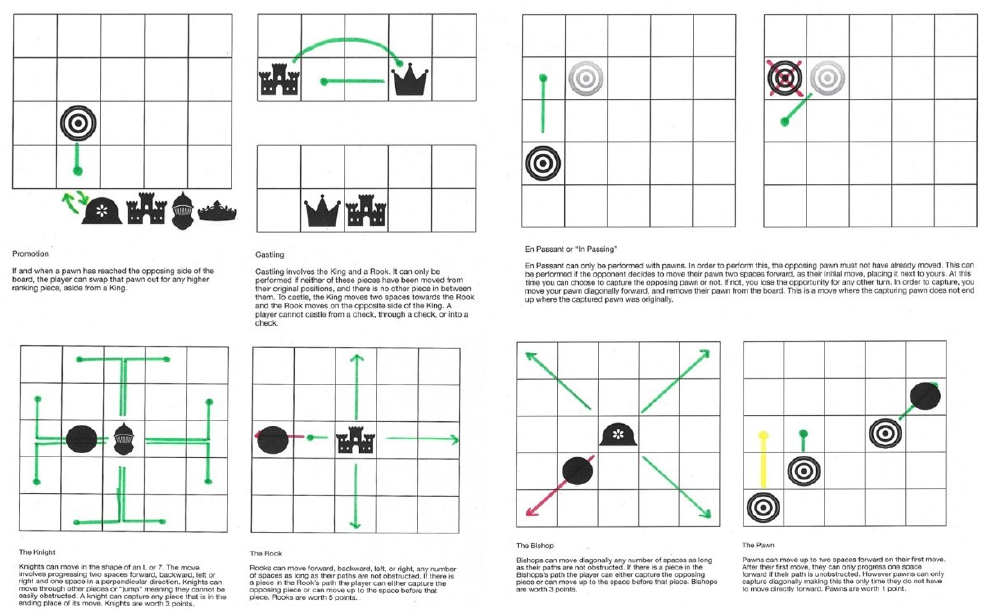
Figure 5 Students were challenged to diagram and analyse the behaviours of individual pieces and traditional moves in the game of chess to generate a typology of operations for design and fabrication of an original half set (Source: Emilee Lemmer,